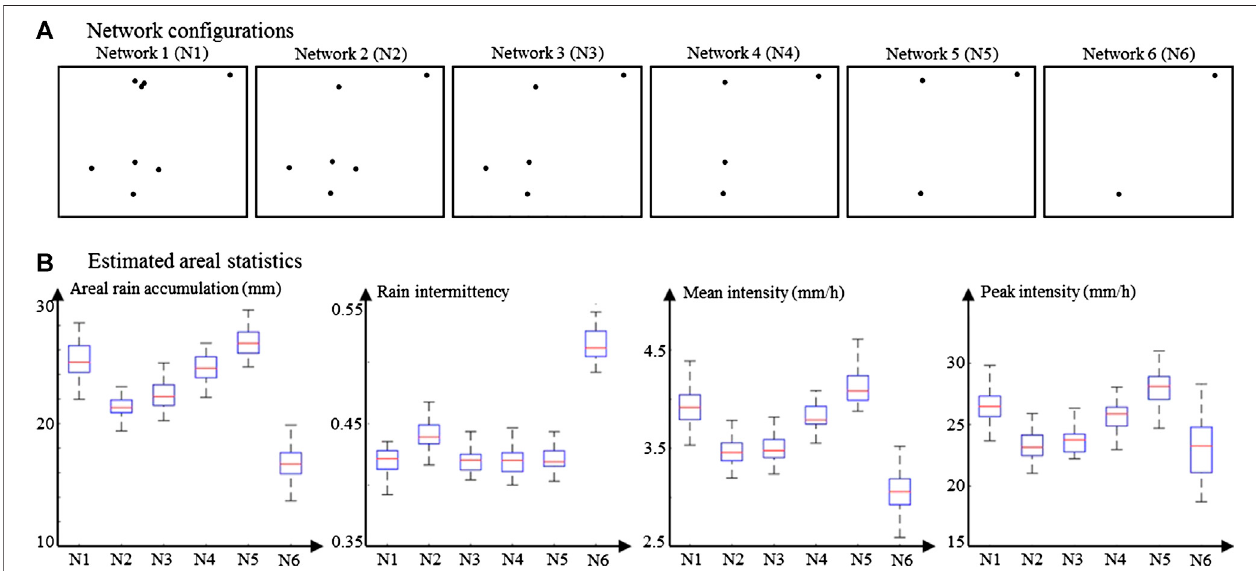
FIGURE 5| Impact ofnetworkcon fi guration on estimated rain statistics, evaluated for rain event 3. (A) Network con fi gurations tested in the sensitivity analysis. (B) Areal rain statistics estimated from the six network con fi gurations presented in (A) . The target statistics are (from left to right): mean area rain accumulation, rain intermittency, mean rain intensity and peak